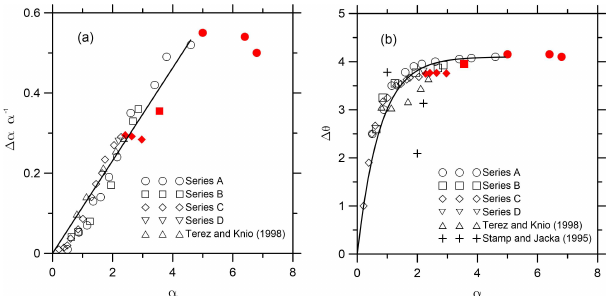
Figure 3. Wave profile of a wave before (a) and after (b) collision in section x L (b) for α = 0 . 81 (case A2; A2). These profiles are compared with the profile of the BO soliton.